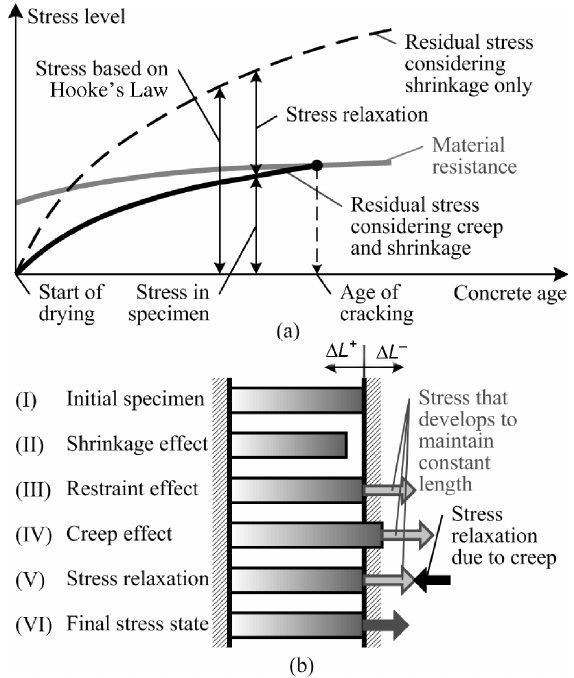
Fig. 4. Stresses in a restrained concrete member due to shrinkage and accompanying creep (Weiss 1999: 145): a – stress development and b – conceptual description of re- laxation Deformational behaviour of plain and RC members